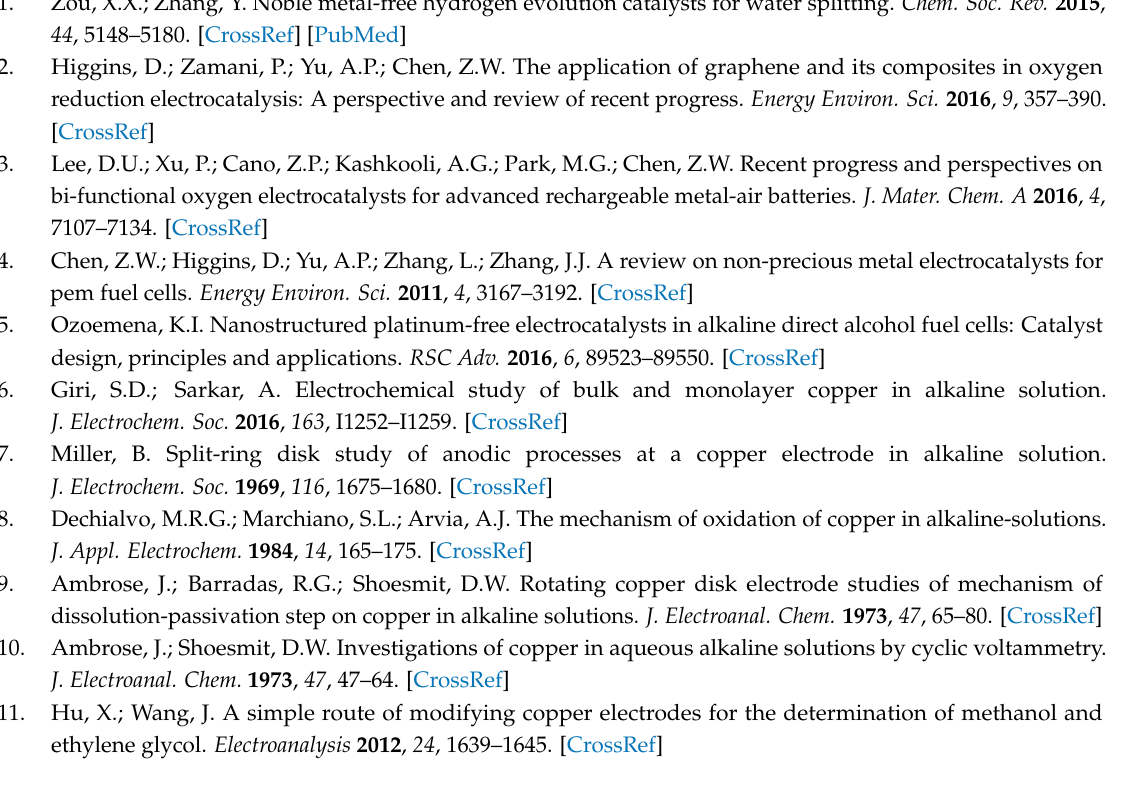
Figure S1: XPS spectra of the main Cu 2p3/2 signal for all samples, Figure S2: Representative TEM images, Figure S3: Cyclic voltammograms of the electrochemical response of undoped S